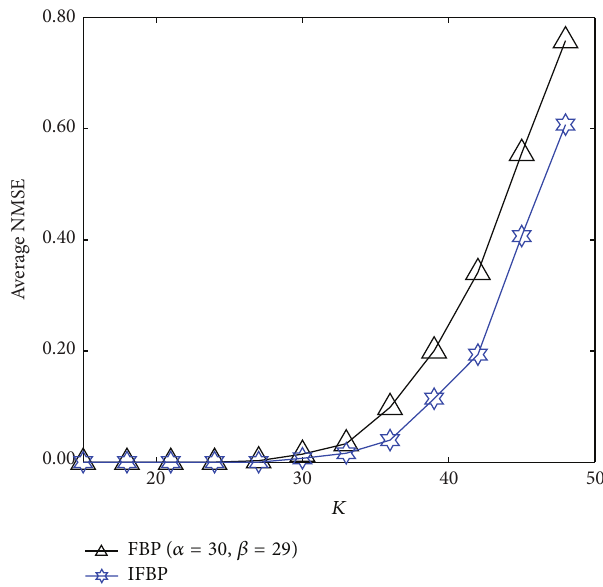
Figure 8: Average NMSE for the uniform sparse vectors ( 𝛼 = 30 , 𝛽 = 29 ).